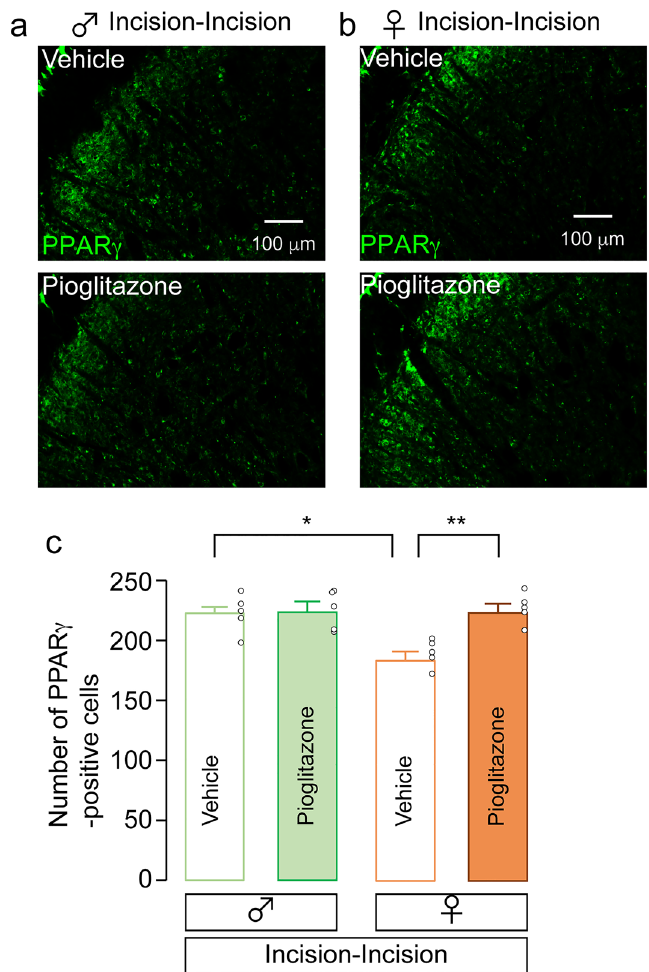
Figure 5. The effects of pioglitazone on the number of PPARγ-positive cells in the Vc of Incision-Incision rats. ( a, b ) The representative images of PPARγ immunofluorescence in the Vc of male ( a ) and female rats ( b ) 10 days after whisker pad skin re-incision. Scale bars = 100 µm. ( c ) The columns represent the mean number of PPARγ- positive cells in the Vc 10 days after whisker pad skin re-incision. Data represent the mean ± SEM. n = 5 in each, two-way ANOVA post hoc Tukey’s test, * p = 0.0105, ** p =